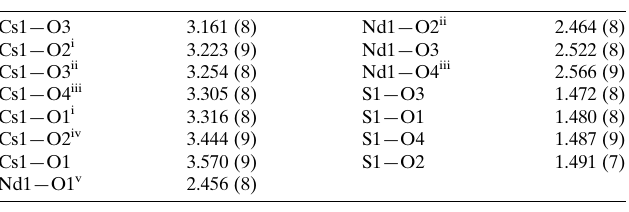
Table 1 Selected bond lengths (A˚